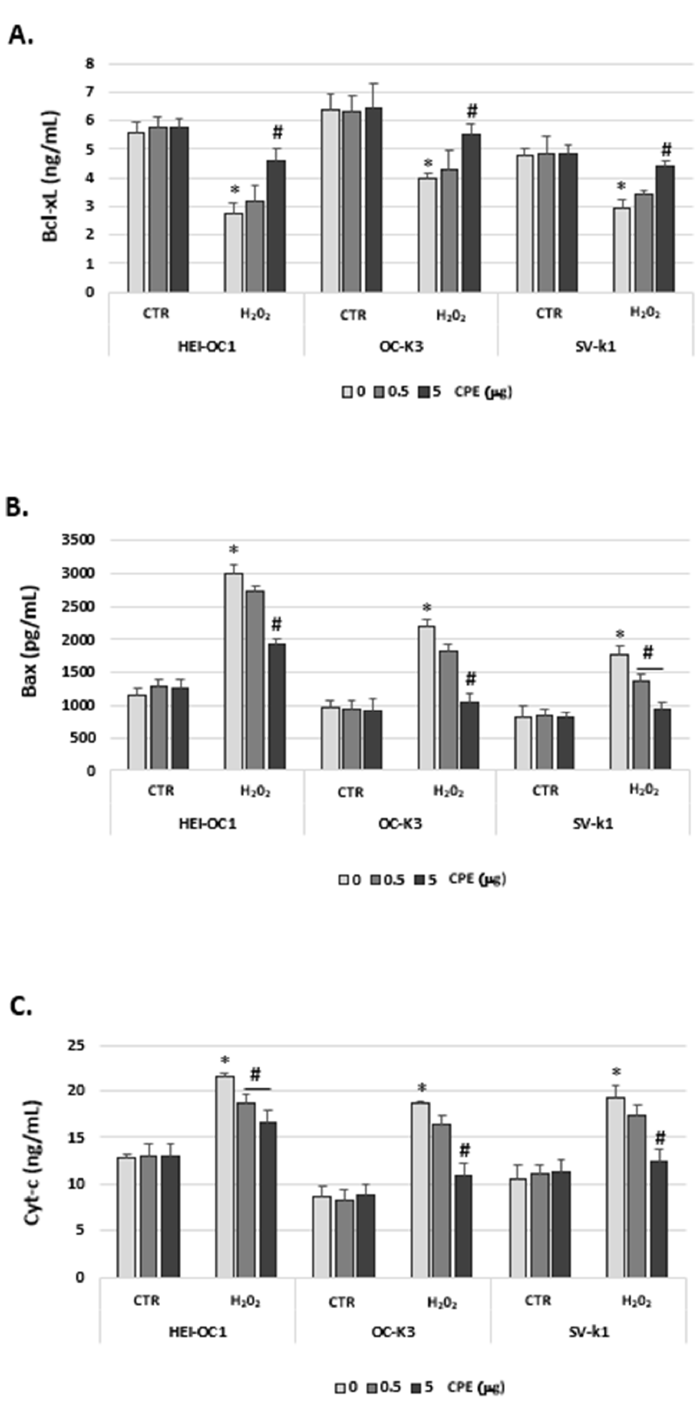
Figure 12. Cocoa treatment impaired the mitochondrial-initiated cell death pathway in auditory senescence cells. The Bcl-xL ( A ), Bax ( B ) and cytochrome c ( C ) levels were measured by a colorimetric assay in cell lysates of HEI-OC1, OC-k3, and SV-k1 cells post-treatments. Experimental groups: CTR group (0; 0.5 and 5 μ g/mL of CPE) and H 2 O 2 group (induced cellular senescence with 100 µ M for 1 h in all groups: 0; 0.5 and 5 μ g/mL of CPE). The values represent the mean ± SD ng/mL or pg/mL in triplicate. * p < 0.05 vs. CTR group; # p < 0.05 vs. H 2 O 2 group ( n = 4).